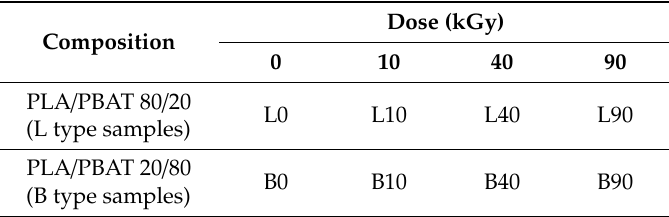
Table 1. Symbols of the studied